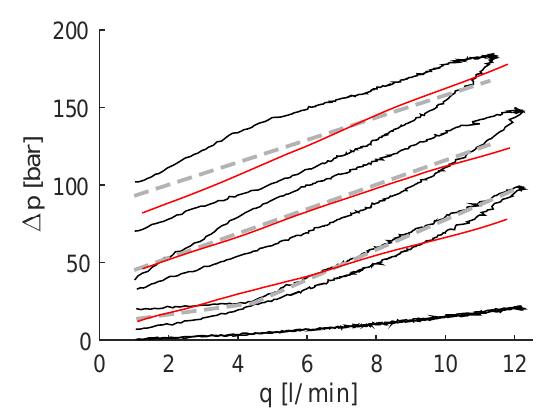
Figure 19: Model without friction(red), data(black), Median curve(gray) for HV at 40 ◦ C.